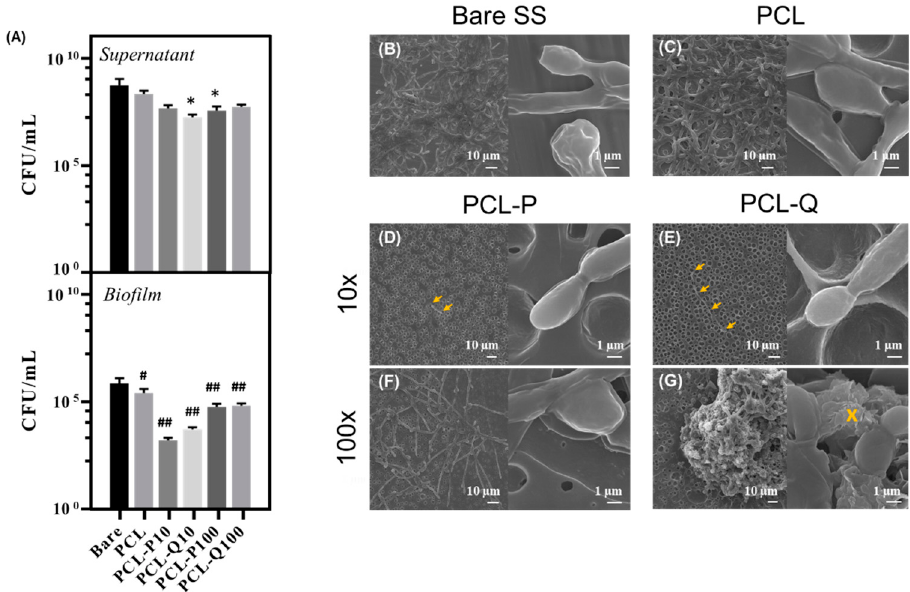
Figure 5. Colonization of bare SS, PCL and bioactive PCL coatings with P or Q compounds by C. albicans SC5314 incubated under simulated physiological conditions; graphical representation of CFUs/mL values obtained for each plate in the supernatant and biofilm ( A ), SEM micrographs of the bare SS plate ( B ), and PCL ( C ), PCL-P10 ( D ), PCL-Q10 ( E ), PCL-P100 ( F ) and PCL-Q100 ( G ) coatings, where the right hand-side SEM images are magnified yeast cells; Bars represent average errors and * or # p -values below 0.05 when compared with the corresponding control, while ## p -values below 0.001; Arrow marks point for isolated yeast cells; cross marks for particles predominantly composed by silver.